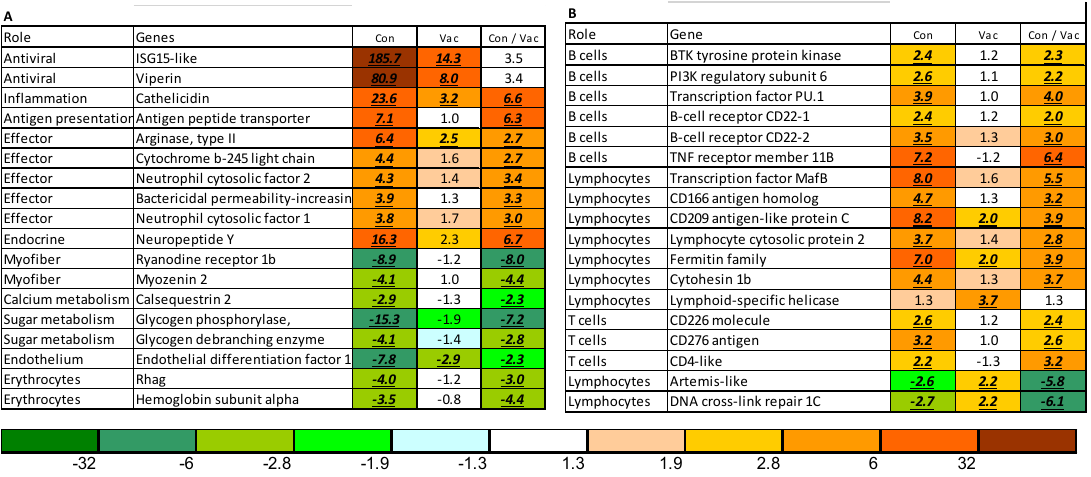
Figure 5. Functional groups of genes with coordinated expression changes in hearts of SAV-challenged Atlantic salmon at 21 dpc in vaccinated fish (vac) versus unvaccinated controls (con). The numbers of differentially expressed genes are in parentheses (saline control/vaccinated). Data are mean log2-expression ratios (infected to intact control) ± Standard Error. All differences between vaccinated fish and saline control are significant.